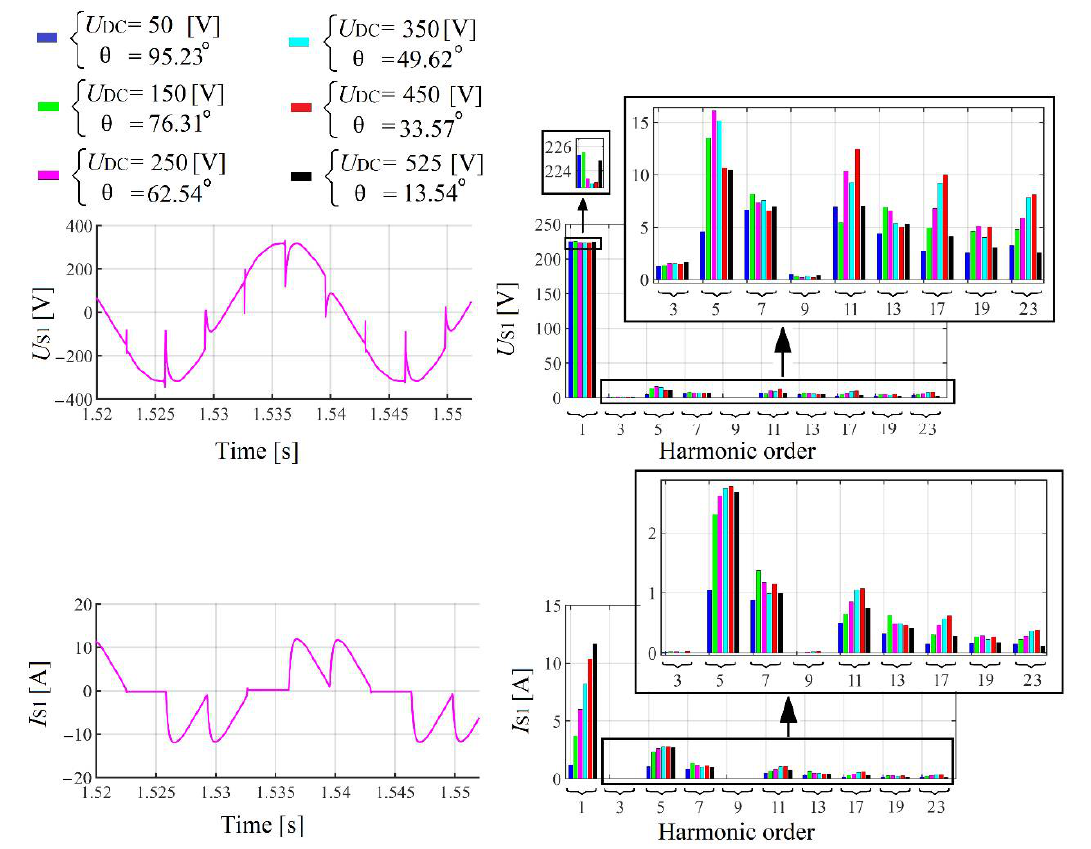
Figure 40. Grid voltage and current waveforms together with the spectrums (with L SS ).